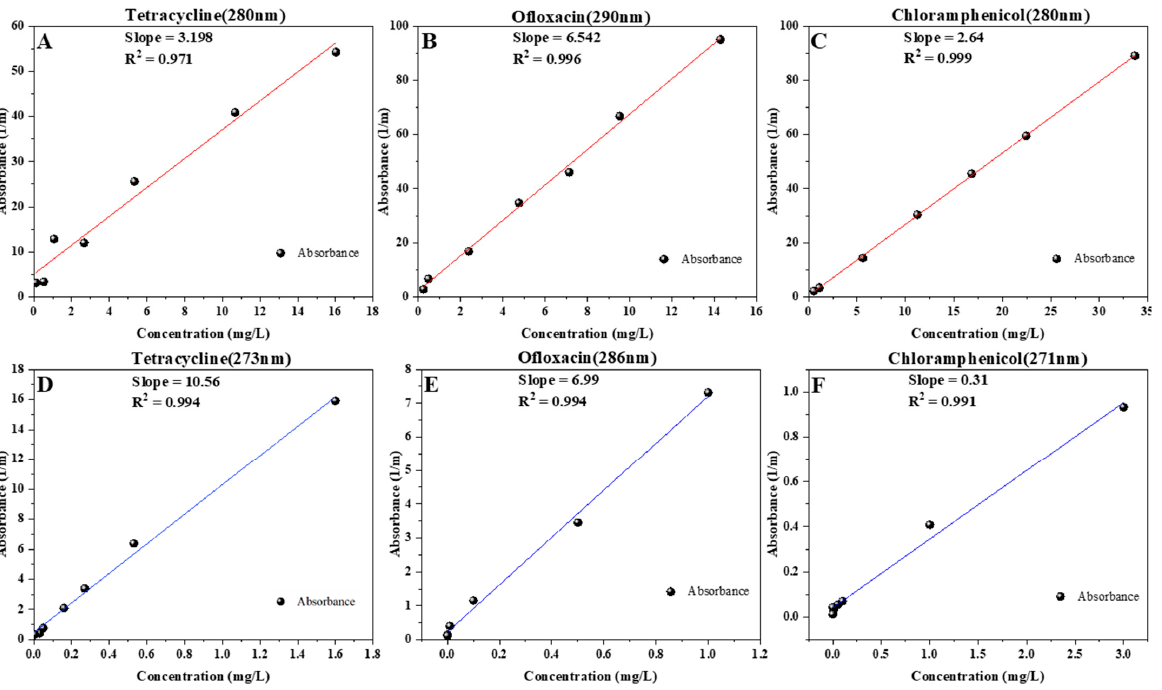
Figure 2. Linear fitting between the absorbance of three antibiotics by Sensor 1 ( A – C ) and 2 ( D – F ) and concentration at the absorption peak.